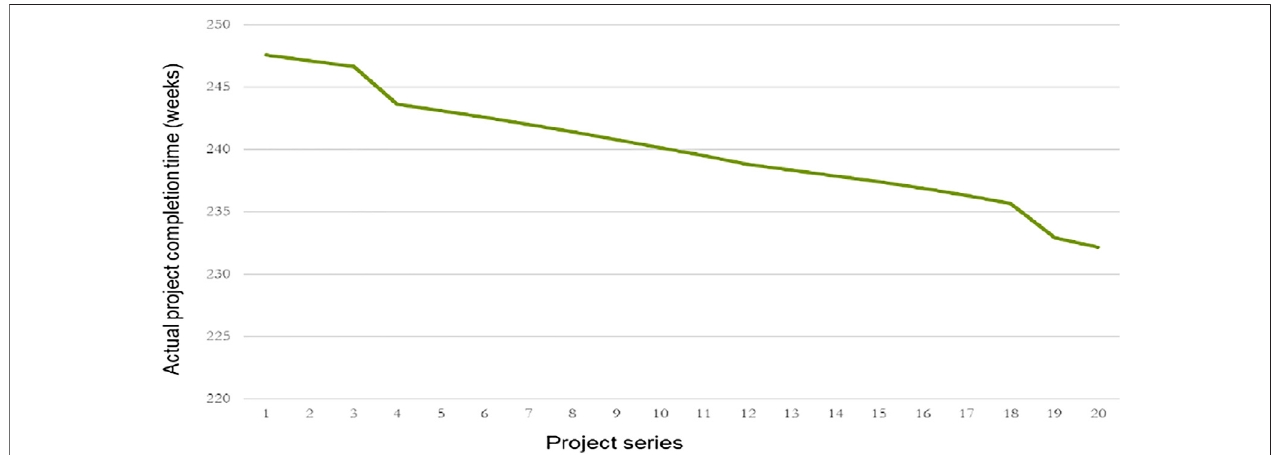
FIGURE 5 | Simulation results of the DEMATEL – SD model of construction delay.